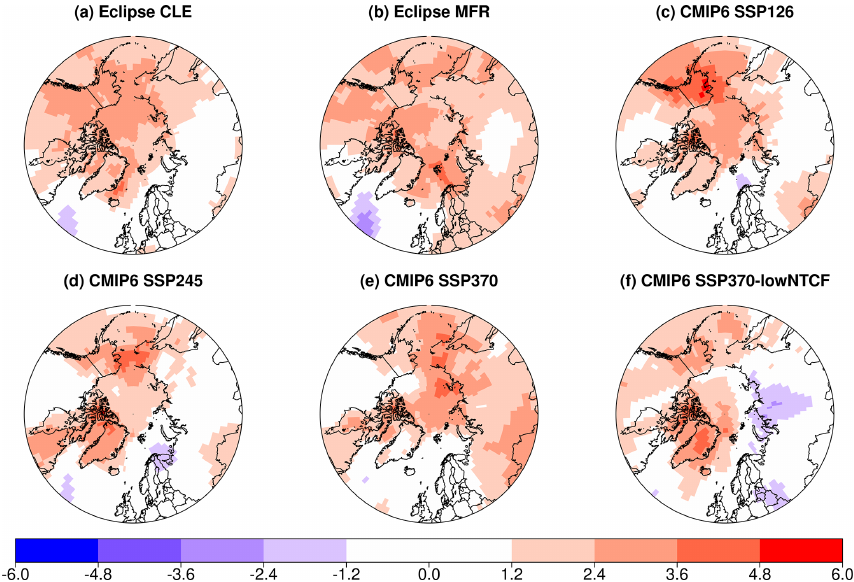
Figure 11. Spatial distribution of the statistically significant annual mean Arctic surface air temperature ( ◦ C) changes between the 1990–2010 mean and the 2030–2050 mean as calculated by the GISS-E2.1 ensemble.